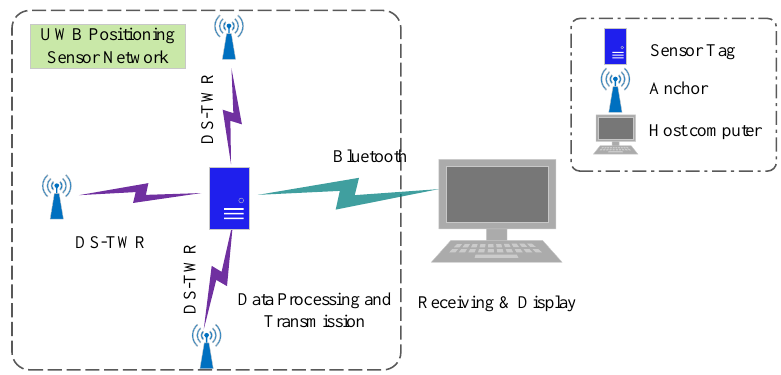
Figure 4. Schematic diagram of ultra-wide band (UWB) positioning system.